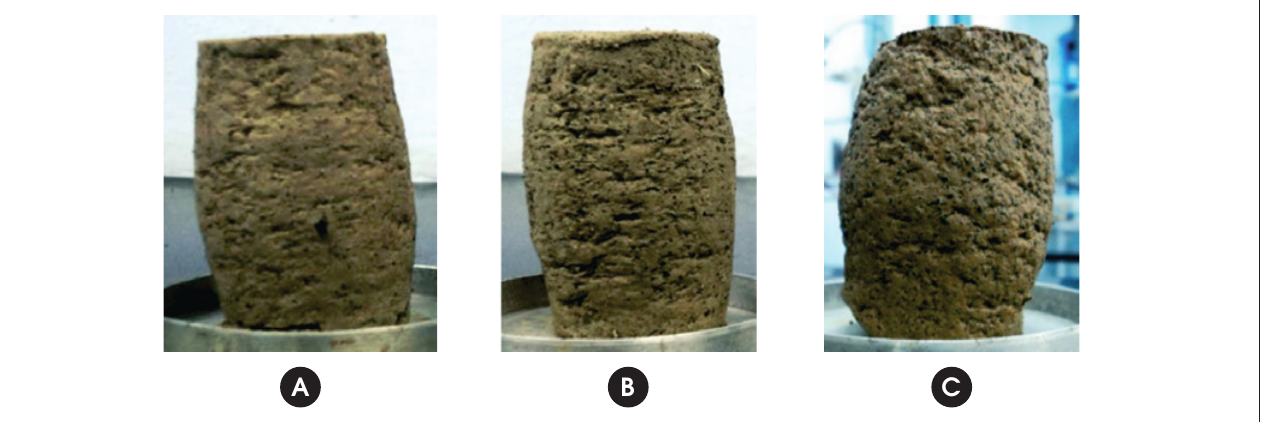
Figure 2 – Example of application of reinforced concrete circular cross section elements working beamsFigure 8 – Sheared mixture speciemens. Confining stress: (a) 100 kPa, (b) 200 kPa and (c) 400 kPa as beams in a shallow tunnel (Maffei, [9]): (a) details of the reinforcement; (b) concluded